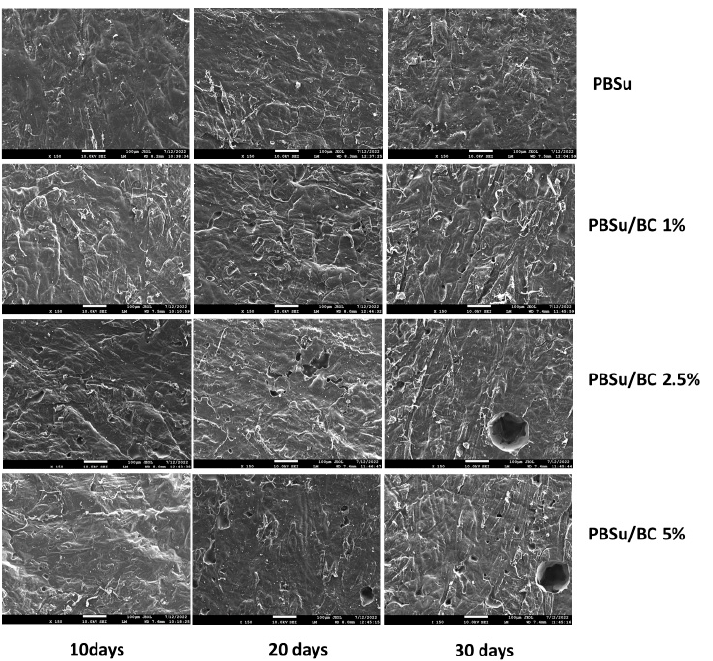
Figure 17. SEM micrographs of PBSu, PBSu/BC 1 wt%, PBSu/BC 2.5 wt%, PBSu/BC 5 wt% during enzymatic hydrolysis at different times (10, 20, and 30 days).